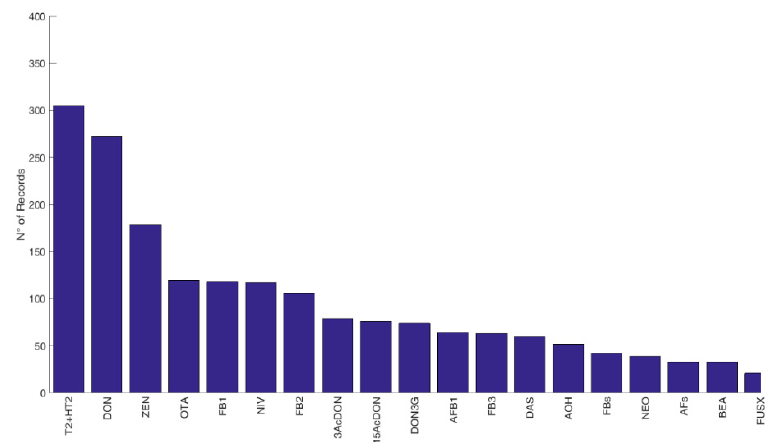
Figure 2. Frequencies of reported mycotoxins and secondary metabolites in feed in Europe. The figure displays the compounds with a number of records above twenty. N > 20: T2: T-2 toxin, HT2: HT-2